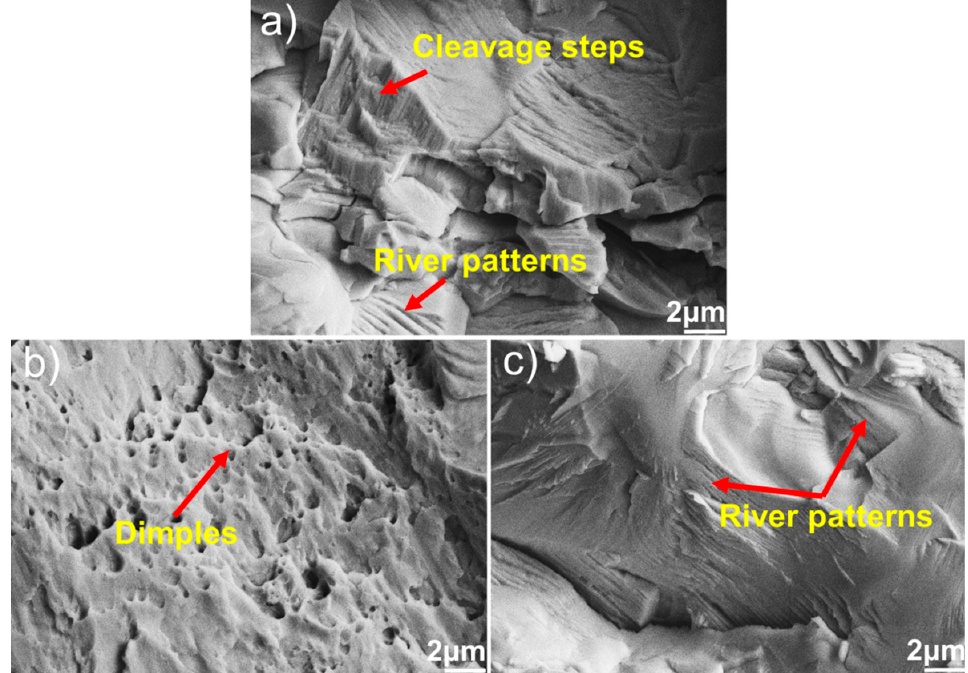
Figure 7. Fracture morphologies of DD98M-DD98M joints brazed at different temperatures for 30 min: ( a ) 1020 ° C, ( b ) 1060 ° C, and ( c ) 1100 ° C.